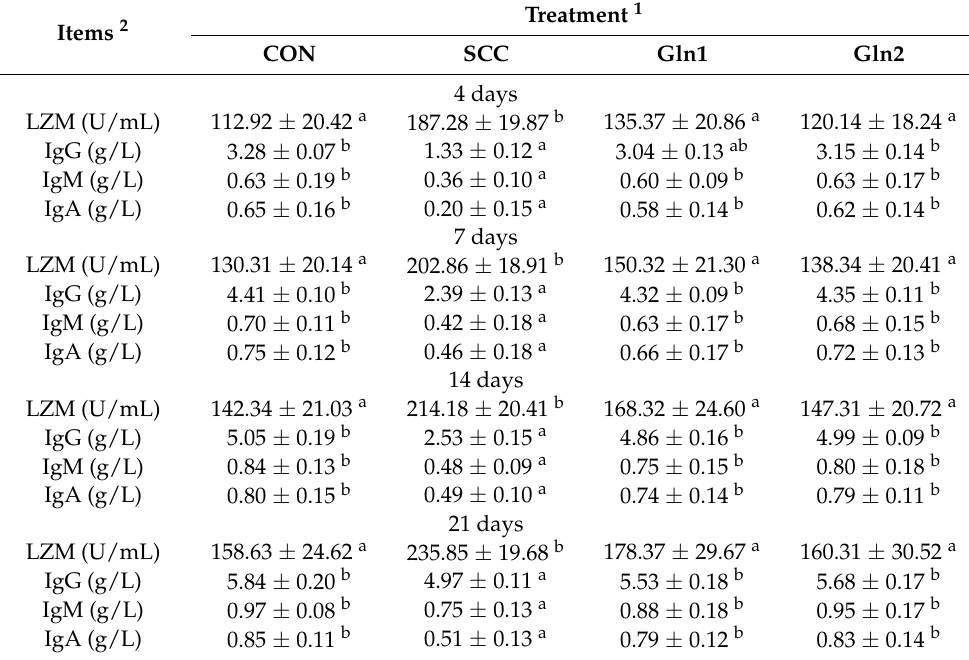
Table 4. Effect of Gln on the LZM and antibodies levels in the serum of broiler chickens that received S .